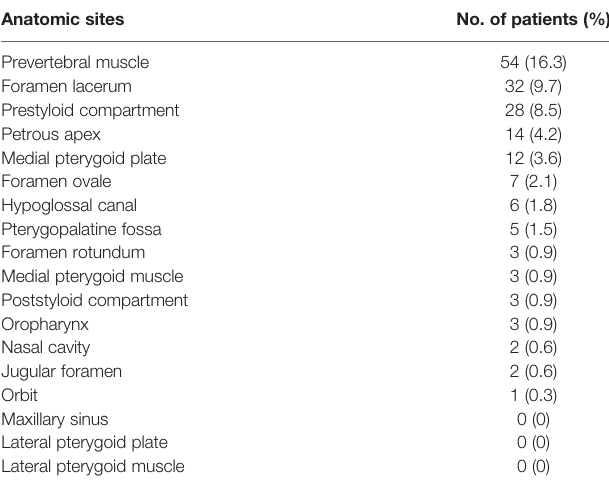
TABLE 4 | Concurrent bilateral tumor invasion into anatomic sites for nasopharyngeal carcinoma. Anatomic